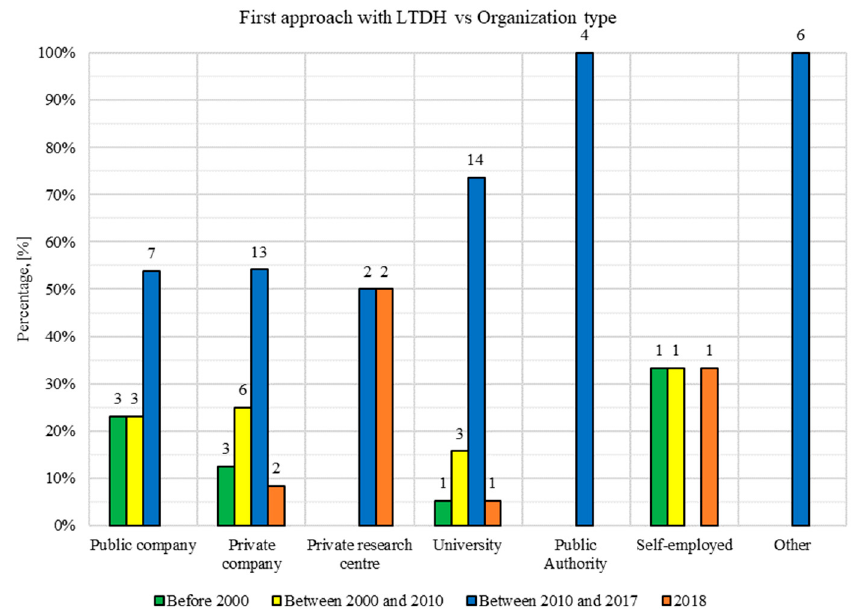
Figure 8. First exposure to the LTDH concept as a function of the organization in which participants are employed.